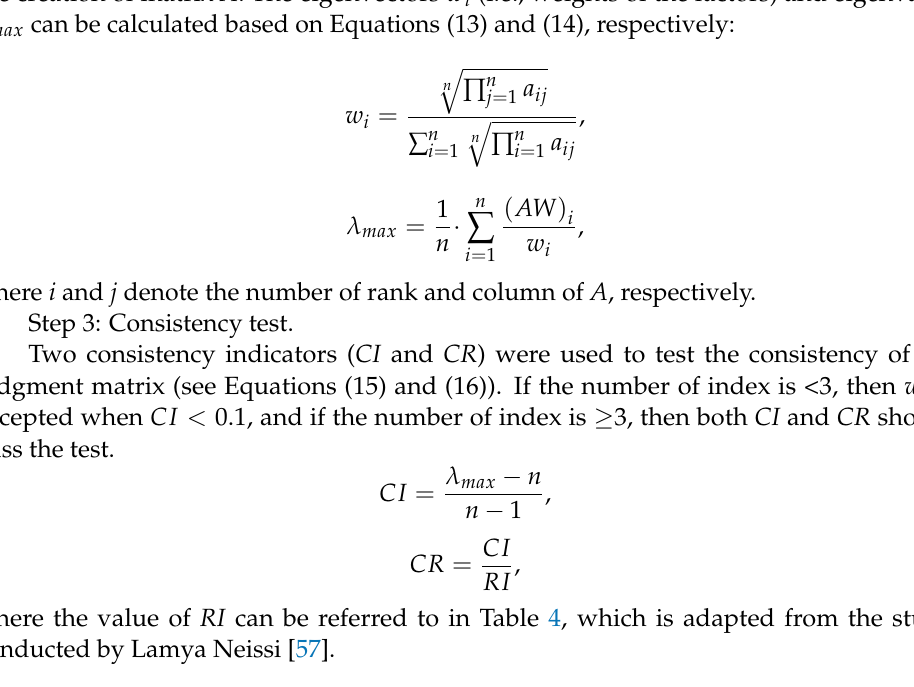
Table 4. Random index ( RI )